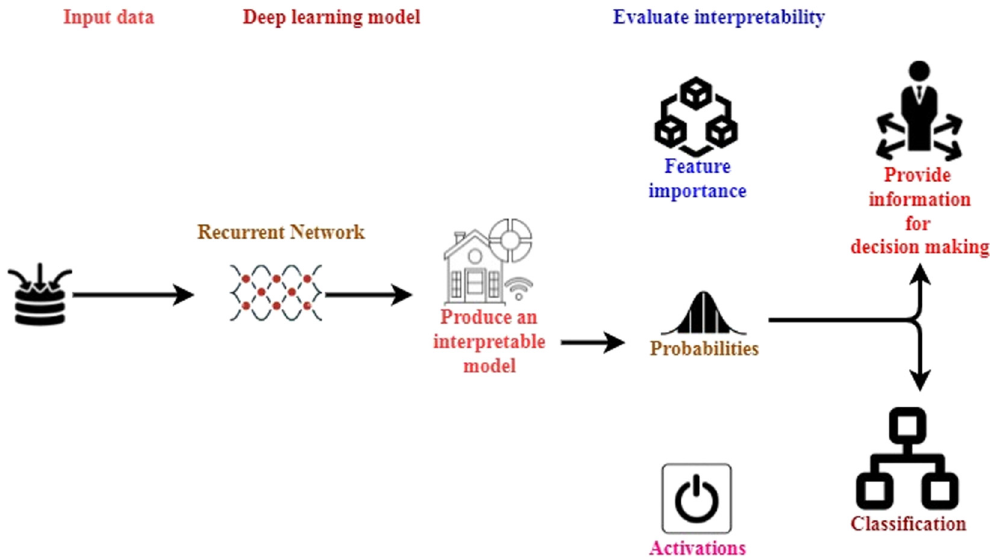
Figure 5: Landscapes in deep